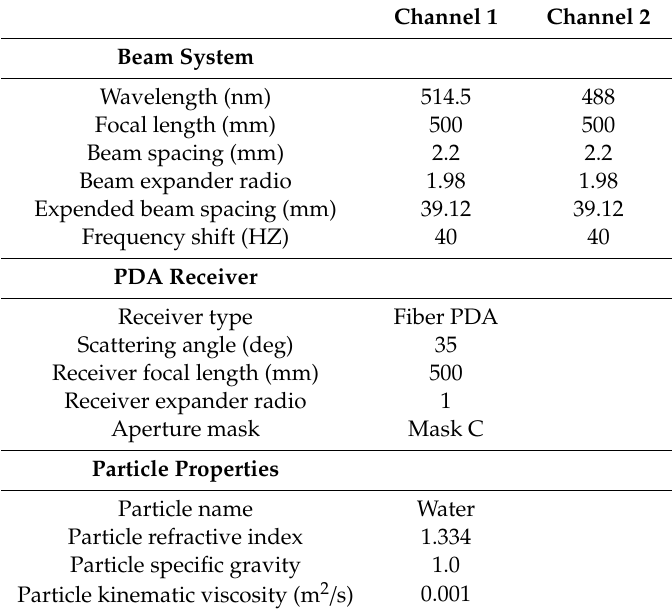
Table 2. Settings and parameters of the PDA